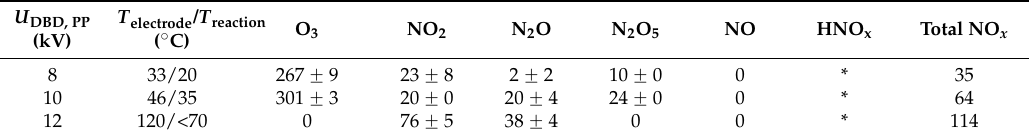
Table 2. Electrode and reaction temperatures, and ozone and NO x concentrations (in ppmv) for three DBD voltages. * HNO x could not be quantified due to significant interference. U DBD,PP